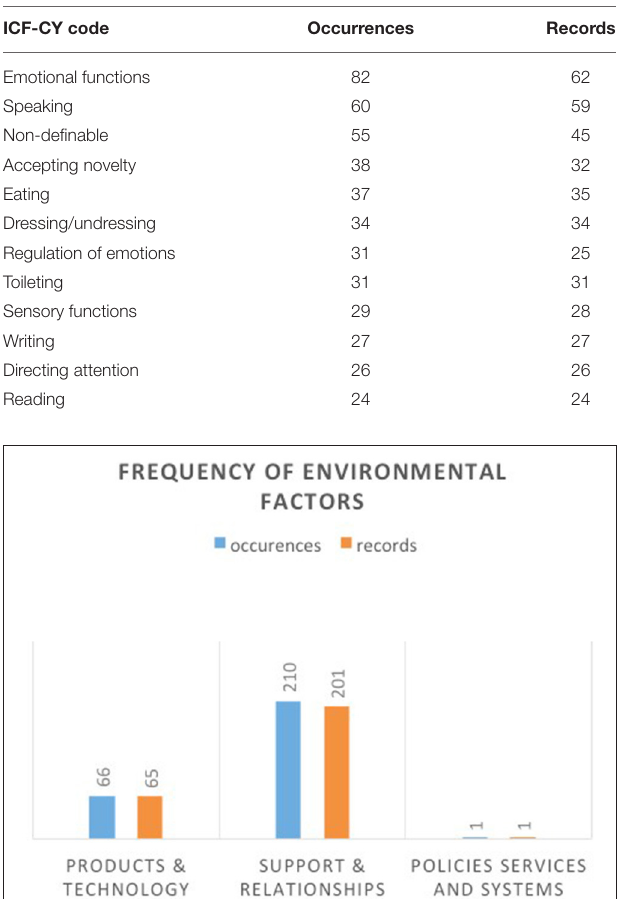
TABLE 3 | Most common ICF-CY codes used to describe functioning issues.